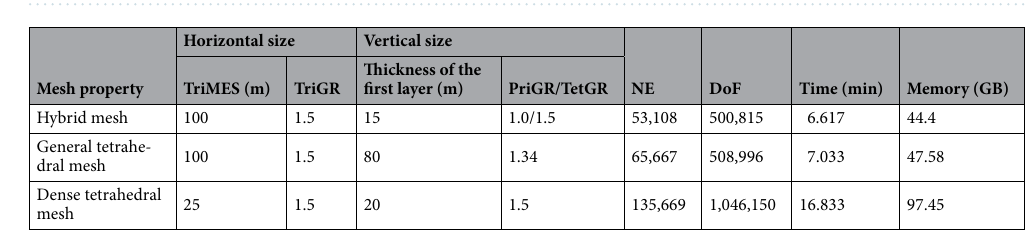
Figure 15. Three-dimensional geoelectric model with complex undulating terrain. ( a ) represents the undulating terrain and the two survey lines. ( b ) represents the whole three-dimensional model 40 .